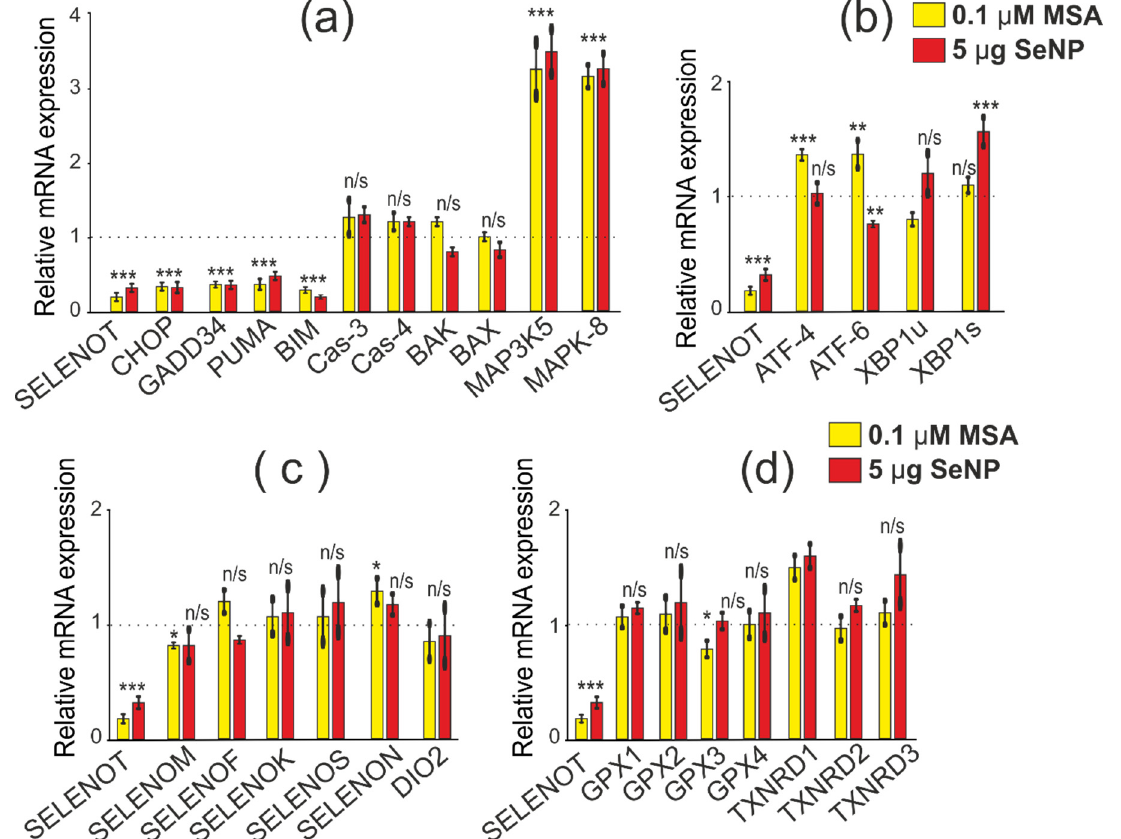
Figure 11. Comparative analysis of mRNA expression patterns of various genes under SELENOT- KD and after 24 h treatment of A-172 cells with 0.1 µM MSA and 5 µg/mL SeNP, obtained using real-time PCR. ( a ) mRNA expression of pro-apoptotic genes; ( b ) mRNA expression of three UPR signaling pathways markers; ( c ) mRNA expression of ER resident selenoproteins; ( d ) mRNA expression of selenium-containing glutathione peroxida44ses and thioredoxin reductases. Compari- son of experimental groups regarding control, indicated as dash line (1): n/s—data not significant ( p > 0.05), * p < 0.05, ** p < 0.01, and *** p < 0.001.